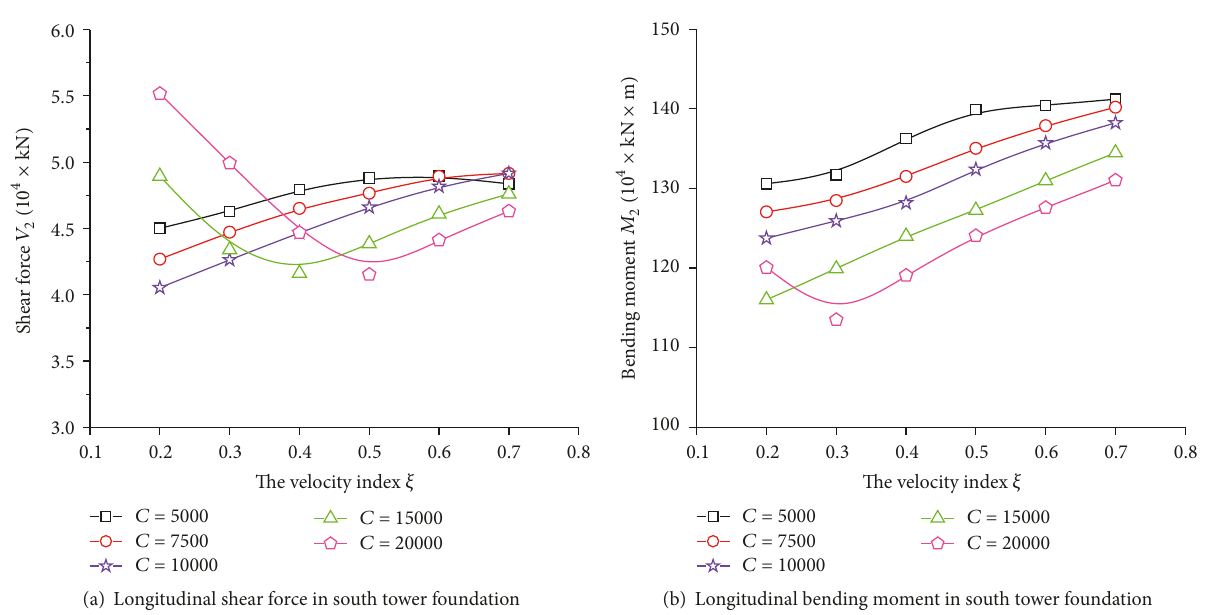
Figure 5: Change of controlled internal force in the south tower foundation with damping